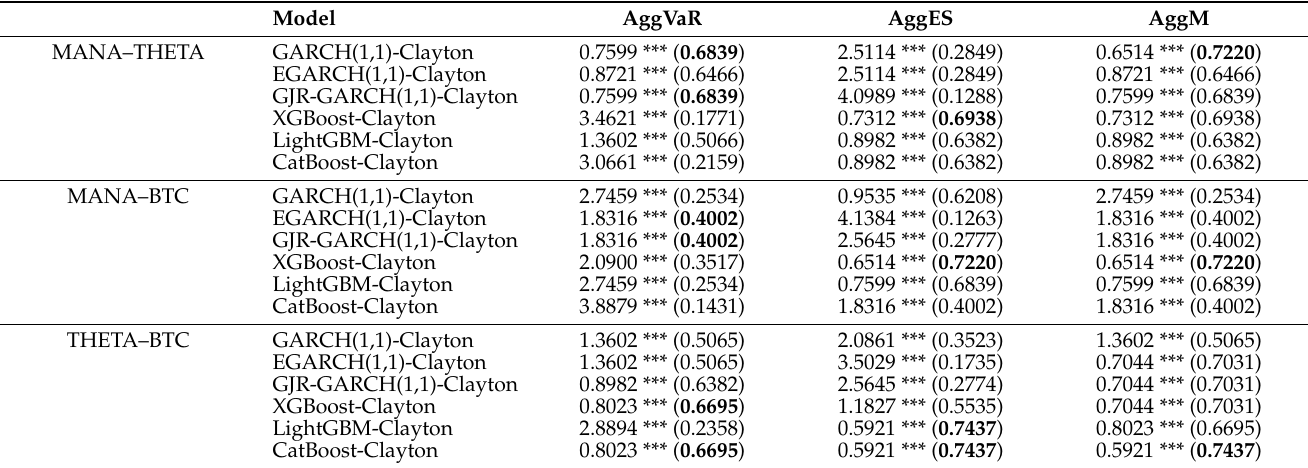
Table 9. Christoffersen’s test statistic for aggregate risk measure forecasts at the 5% level of